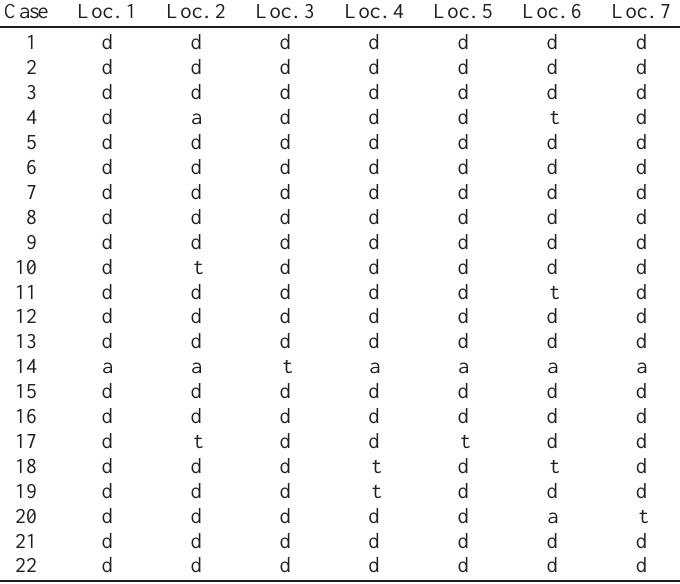
d = DNA-diploid, t = DNA-tetraploid, a =